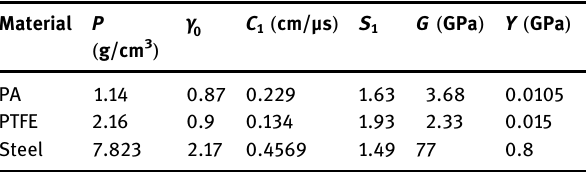
Table 2: Parameters of Shock equation of state for polymers and steel Material P ( g/cm 3 )